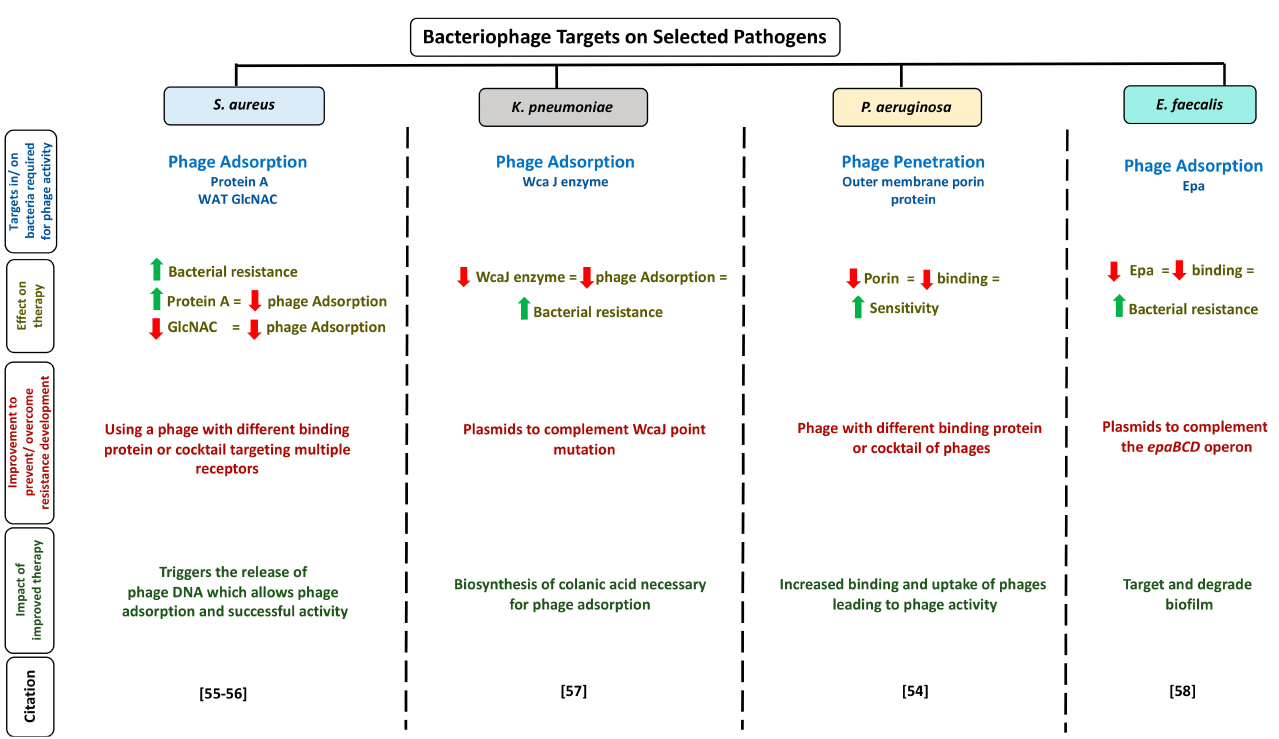
Figure 2. Schematic illustration of selected bacteriophage targets available in the literature. The figure is divided into four columns and five rows. The column headings represent the pathogens, while the rows heading represent targets in/on bacteria required for phage activity, effect of these targets of phage therapy, available methods to improve tar- get to prevent/overcome phage resistance development, the outcome observed if the improved method is used,